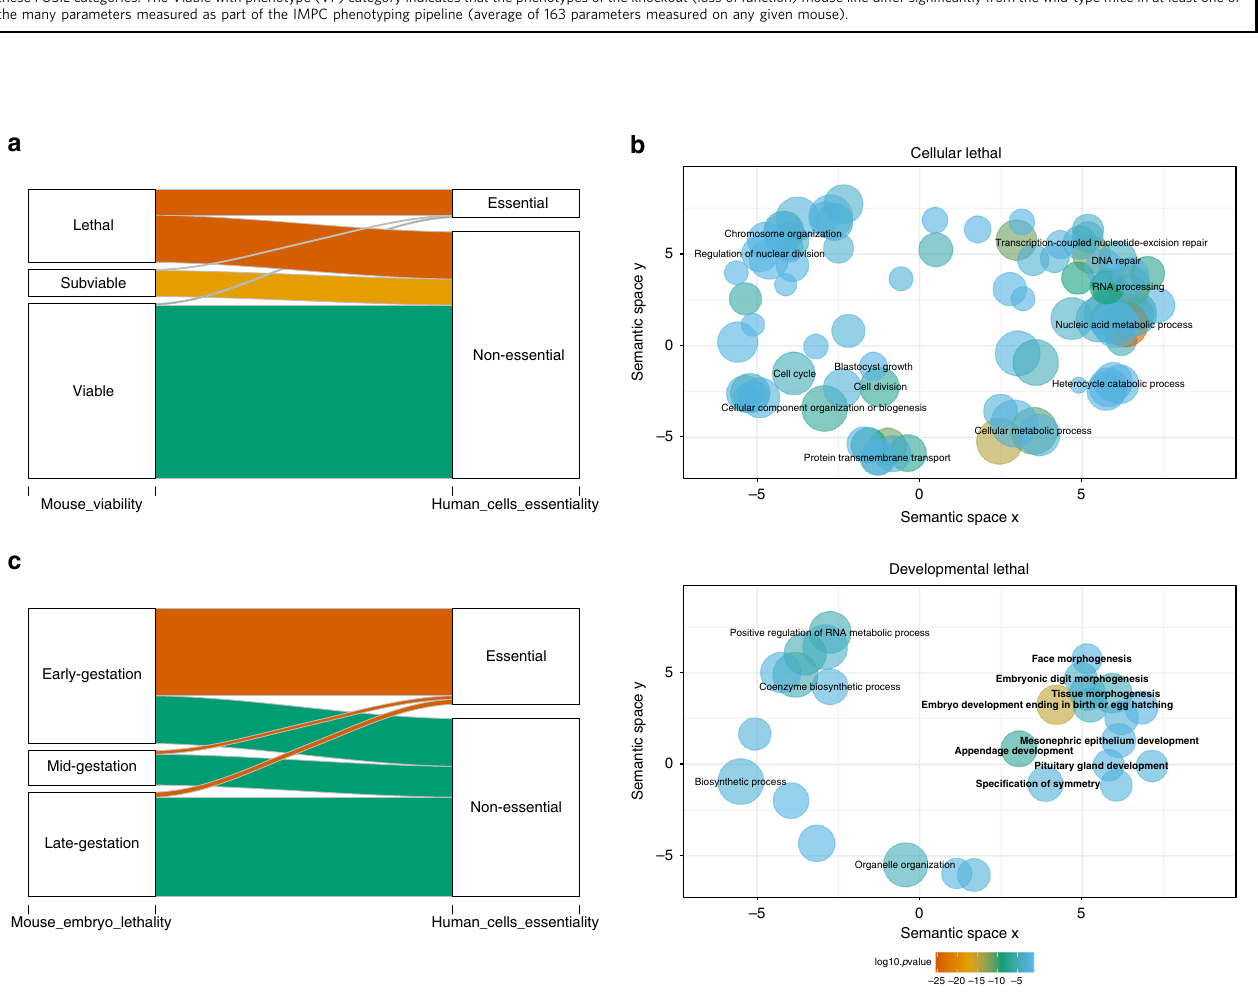
Fig. 1 Cross-species FUSIL categories of intolerance to LoF. a Correspondence between primary viability outcomes in mice and human cell line screens. The sankey diagram shows how human orthologues of mouse genes with IMPC primary viability assessment (lethal, subviable and viable) regroup into essential and non-essential human cell categories; the width of the bands is proportional to the number of genes. b Gene Ontology Biological Process (GO BP) enrichment results. Signi fi cantly enriched GO terms at the biological process level were computed using the set of IMPC mouse-to-human orthologues incorporated into the FUSIL categories as a reference (Table 1) and identi fi ed after correcting for multiple comparisons. Signi fi cant results were only found for the cellular and developmental lethal gene categories. Bubble size is proportional to the frequency of the term in the database and the colour indicates signi fi cance level as obtained in the enrichment analysis. The GO terms associated with embryo development are in bold. c Correspondence between mouse embryonic lethality stage and essentiality in human cell lines. Embryonic lethal LoF strains are assessed for viability at selected stages during embryonic development: early (gestation) lethal (prior to E9.5), mid (gestation) lethal (E9.5 – E14.5/15.5), late (gestation) lethal (E14.5/E15.5 onwards). E embryonic